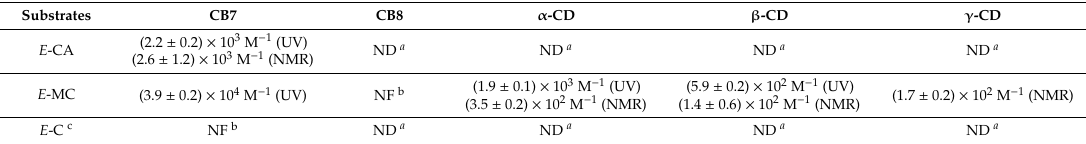
Table 1. Binding constants of E -CA, E -C, and E -MC compounds with di ff erent macrocyclic hosts